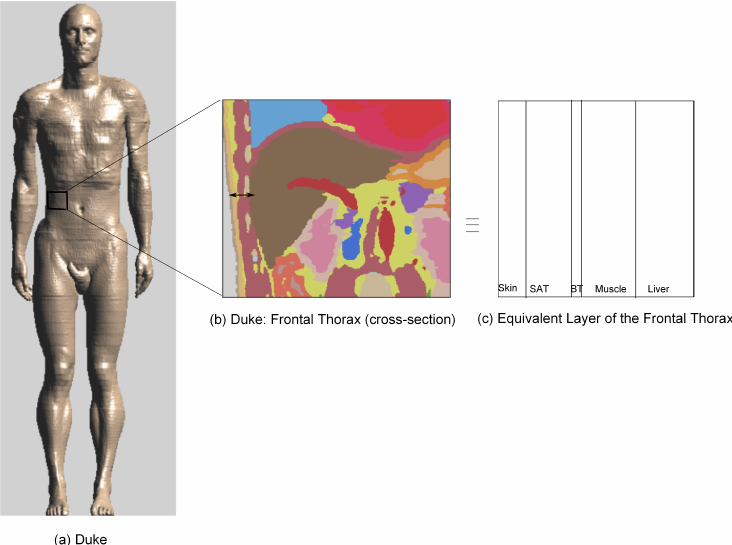
Figure 3. The anatomical adult model: ( a ) Duke, followed by ( b ) the cross-section of the human frontal thorax and ( c ) the equivalent tissue layer of the human frontal thorax.